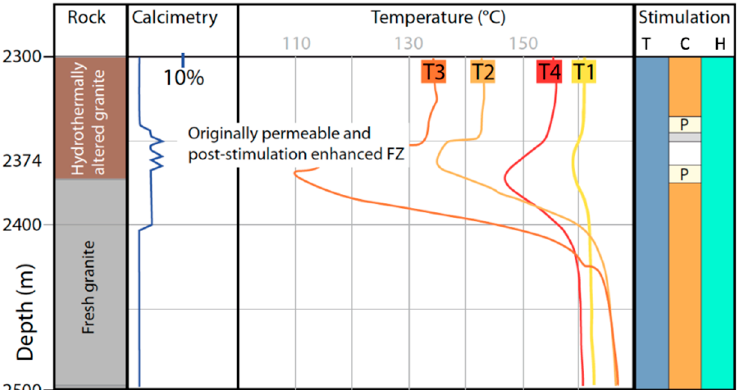
Figure 10. High ‐ resolution temperature profile in the GRT ‐ 1 well at Rittershoffen before ( T1 ) and after ( T2 to T4 ) stimulation. A negative temperature peak is observed at the depth where an anomaly in carbonate content occurs, at the border of a hydrothermally altered zone. Stimulation: blue = thermal ( T ), orange = chemical ( C ), green = hydraulic ( H ). P: packers. (modified after [9]).